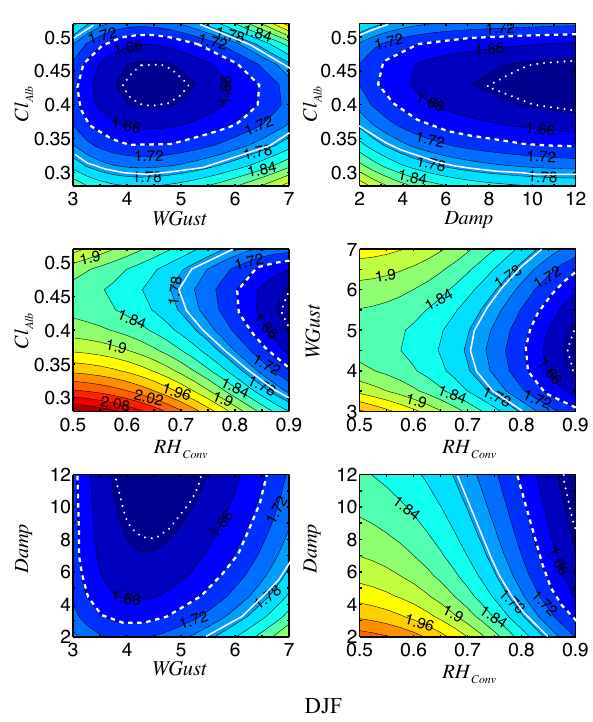
Fig. 3. Pairwise planes of the four-dimensional parameter space showing the root-mean-square globally averaged precipitation error in mmday − 1 estimated by the quadratic metamodel in December– February. The white dotted (dashed; solid) contours indicate regions where the model error increases by 1% (5%; 10%) compared to its minimum value at the parameter optima. Units on axes are ms − 1 for WGust, days for Damp and nondimensional for Cl Alb and RH Conv